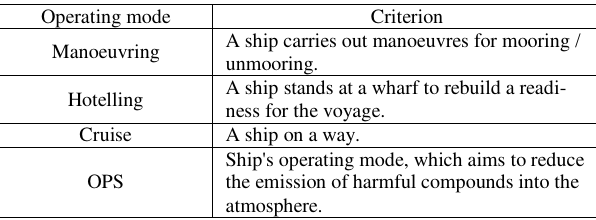
Table 1. Criteria defining ship operation modes